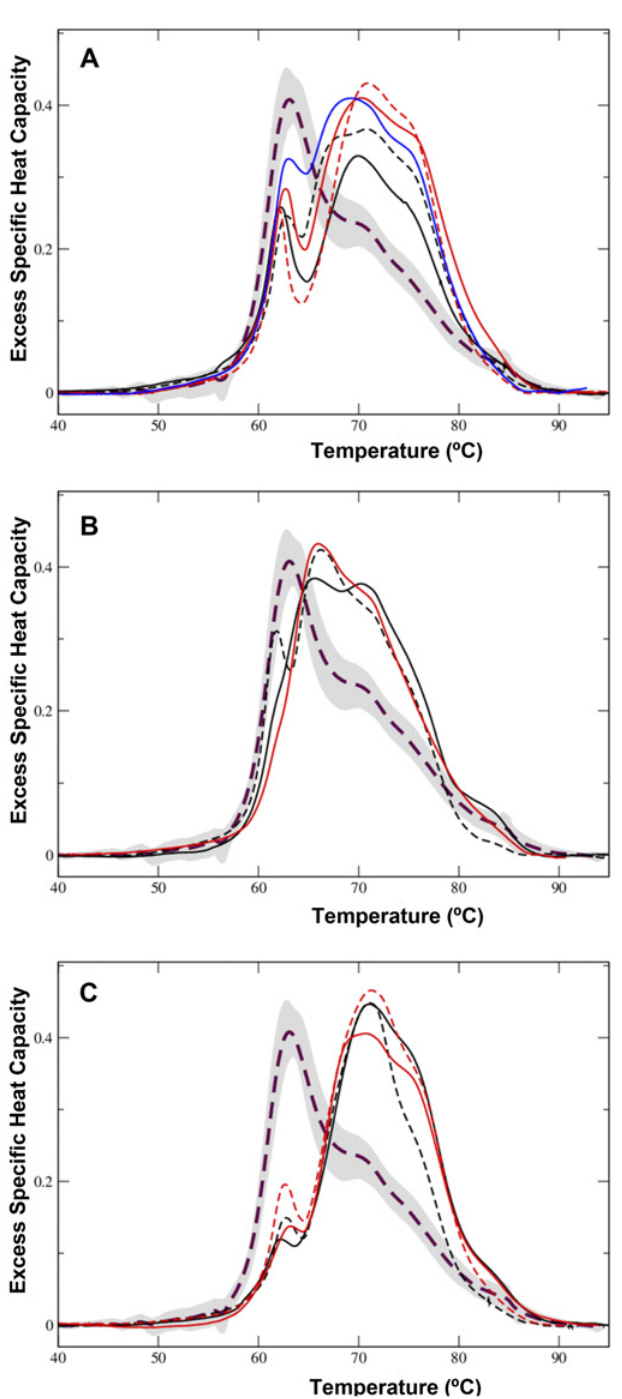
Fig 3. DSC thermograms of serum samples from patients with MGUS- λ . Samples were gathered as MGUS- λ based on the λ light chain that was found associated with the different monoclonal immunoglobulin heavy chains. (A) A set of thermograms of serum samples obtained from patients with IgG λ subtype. (B) A set of thermograms from individuals with MGUS IgG λ subtype (black) or IgM λ subtype (red) grouped together to highlight their similar shape. (C) Several thermograms from patients having IgA λ (continuous black and red plots, and dashed black plot) or IgM λ (dashed red plot) subtypes grouped together because they show similar shapes. For the sake of comparison, the average healthy (control) thermogram is presented in all the panels.